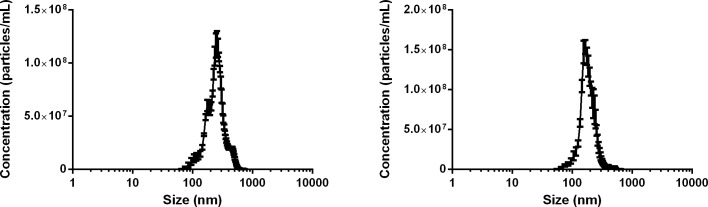
Nanoparticle concentration as a function of particle size (nm).(a) SLN and (b) 15d-PGJ2-SLN performed at 25°C (n = 5).